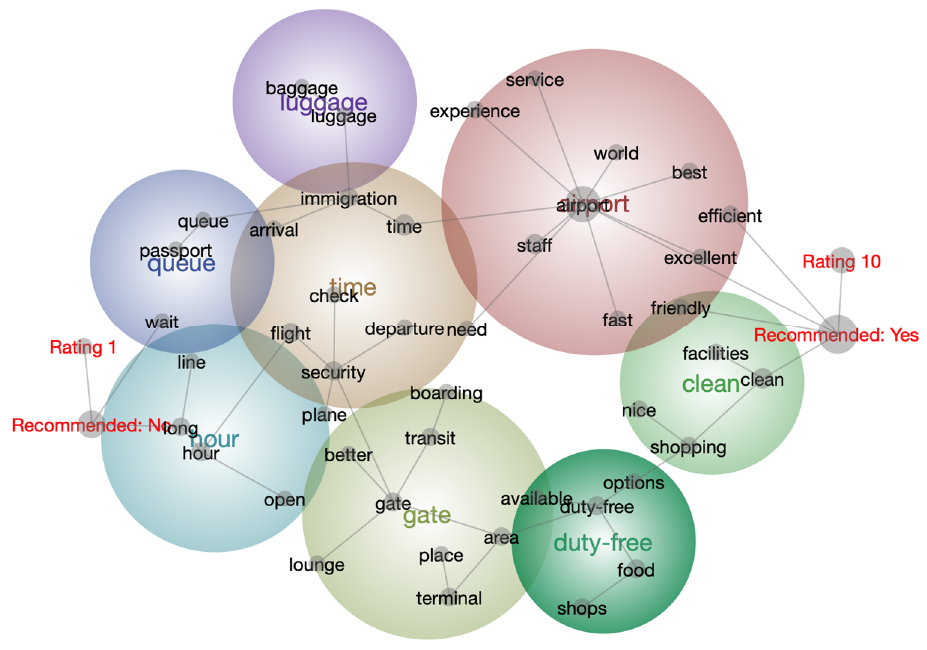
Figure 2. Concept Maps and Overall Ratings for the World’s Leading Airports.